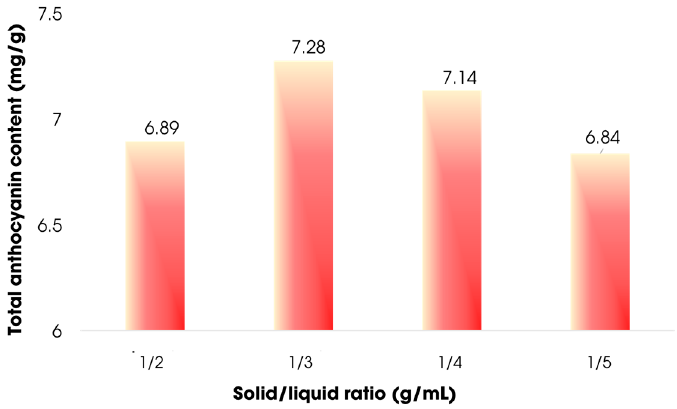
Figure 3. Extraction yields under different solid–liquid ratios.